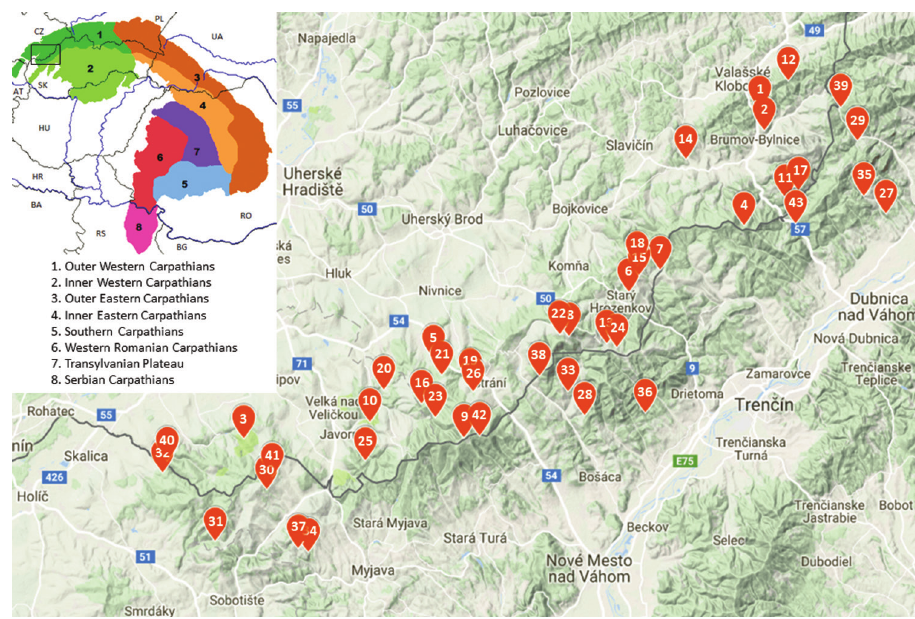
Figure 1. The zonation of Carpathians, with enlarged inset part of position of studied localities in CZ/ SK White Carpathians. Source of the map of the Carpathian zones: https://commons.wikipedia.org/wiki/ File:Mapcarpat2.png accessed 24.7.2018; the map with position of studied localities according to Google